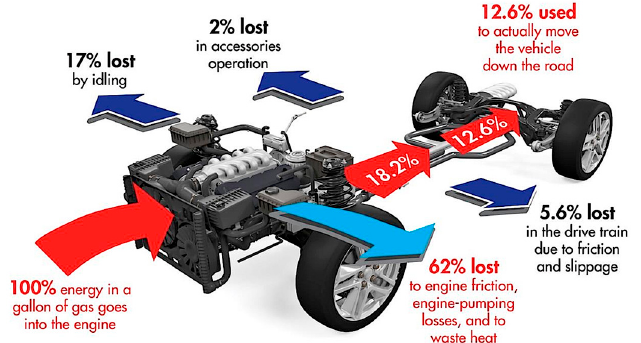
Figure 2. Typical city driving energy pathways.